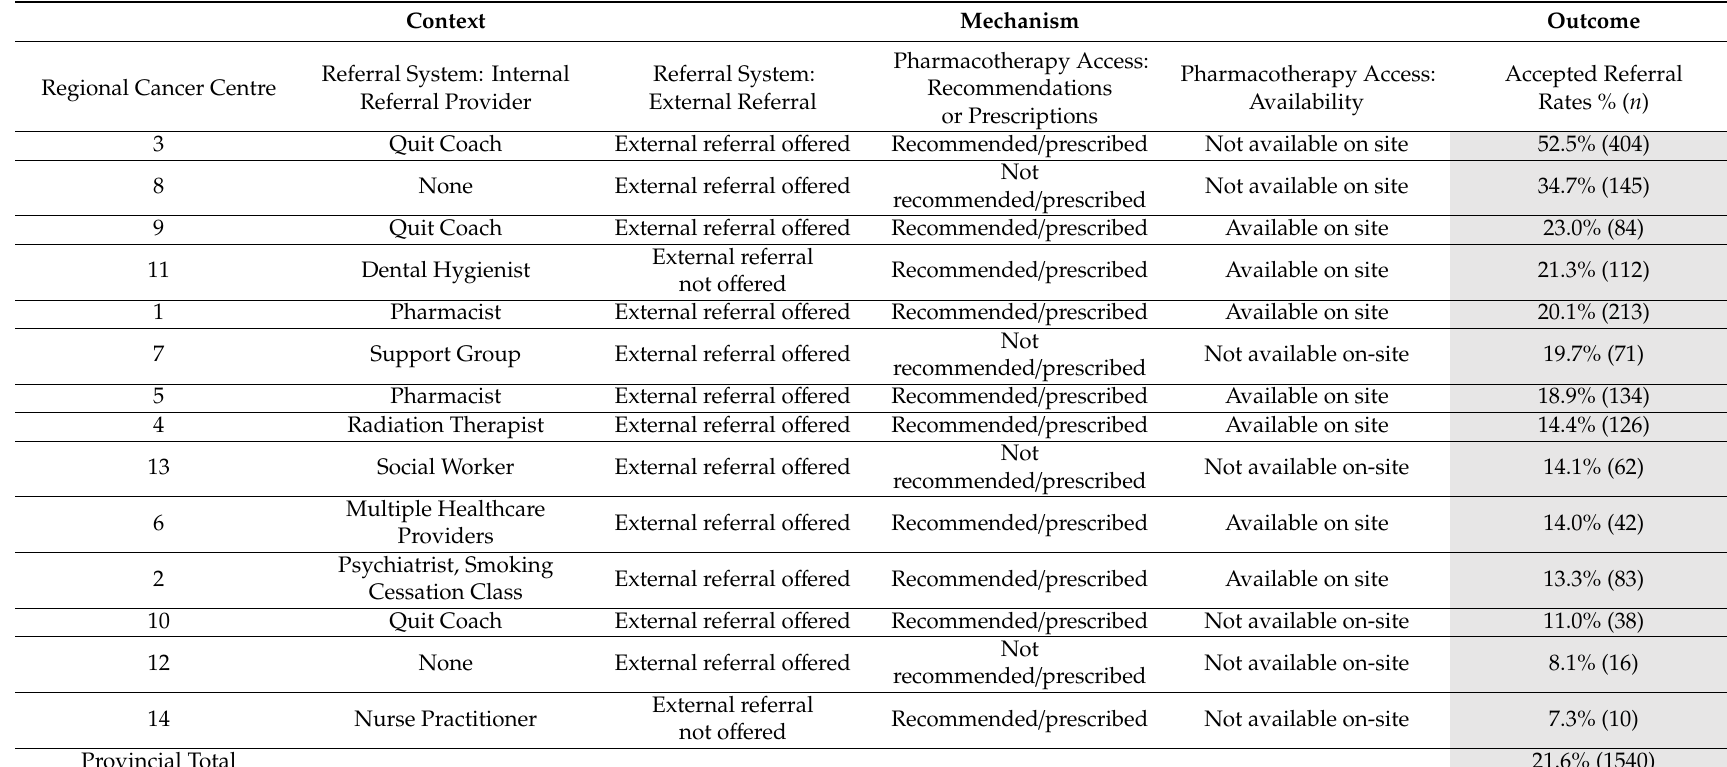
Table 4. Context and Mechanism variables that predict highest accepted referral